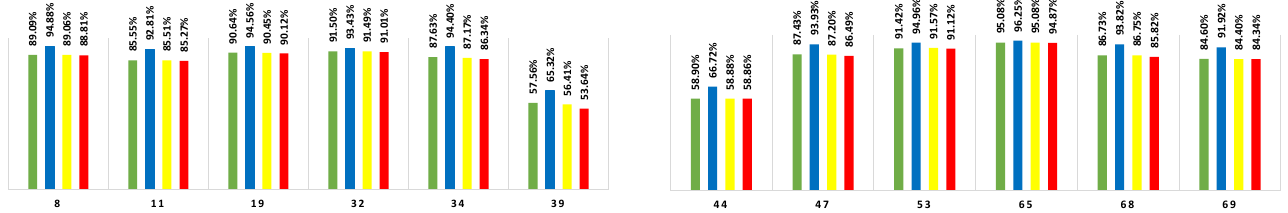
Figure 9. Indoor temperature according to the set-point 19 ÷ 21 ◦ C, percentage of time in different users, comparison of scenarios (Scenario 1 in green, Scenario 2 in blue, Scenario 3 in yellow, and Scenario 4 in red).